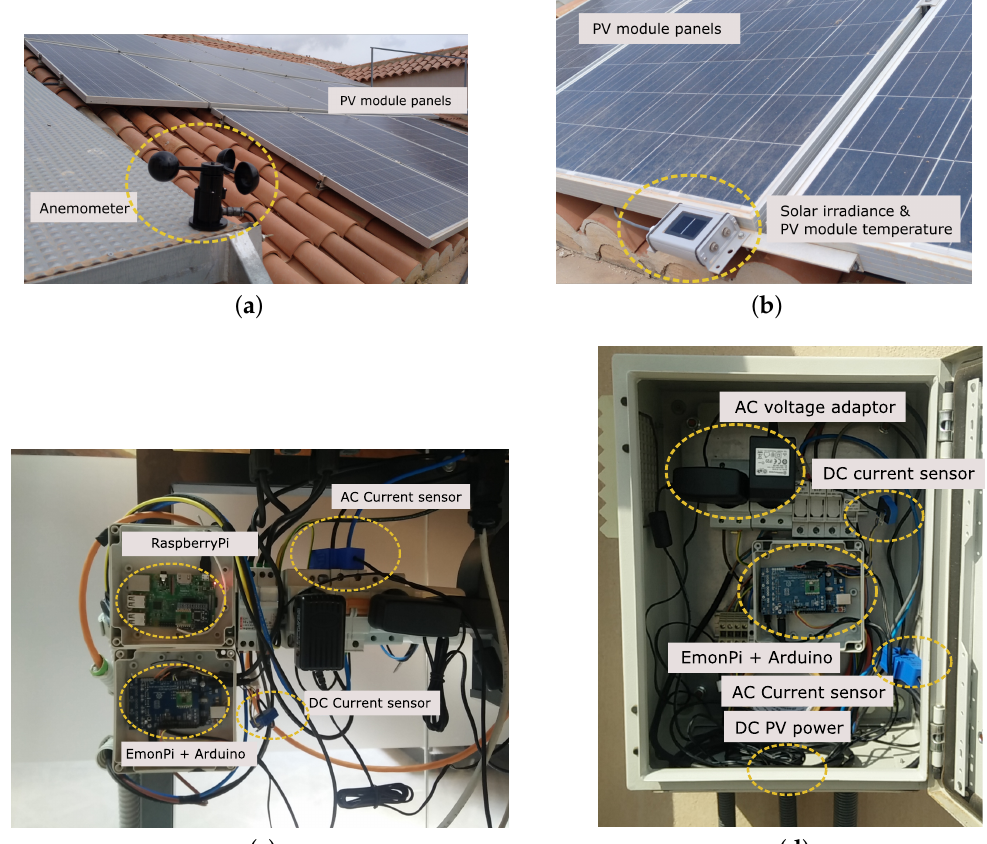
Figure 11. Low-cost proposed system: implementation and details: ( a ) meteorological data monitor; ( b ) DC electrical data (outdoor node); ( c ) AC electrical data (indoor node); and ( d ) DC electrical data (outdoor